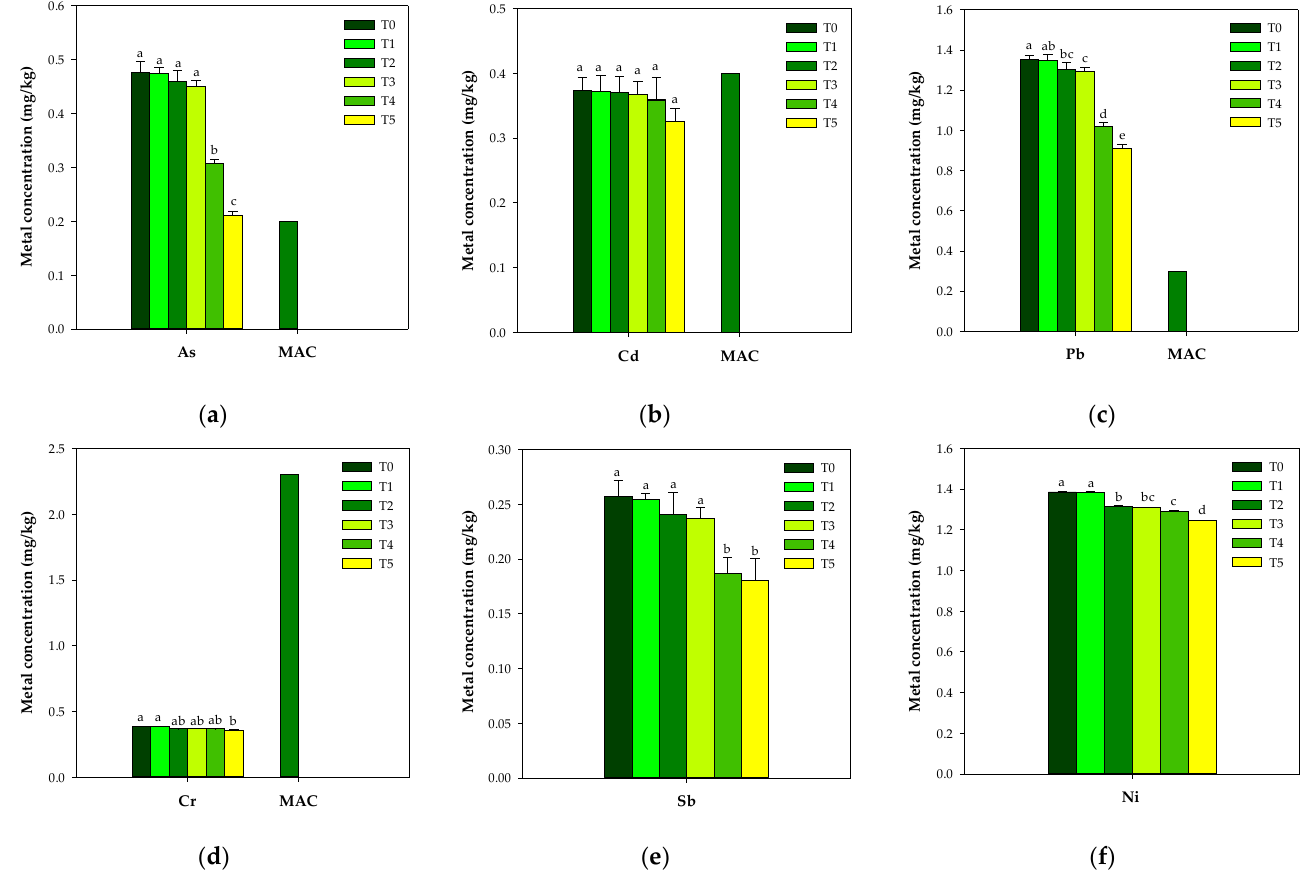
Figure 1. Effect of cooking treatments on As ( a ), Cd ( b ), Pb ( c ), Cr ( d ), Sb ( e ), and Ni ( f ) contents in Hassawi rice; similar letters on bars are non-significant among each other ( p > 0.05); MAC means maximum allowable concentration by FAO/WHO; for Sb and Ni, the maximum allowable concentration is not defined.